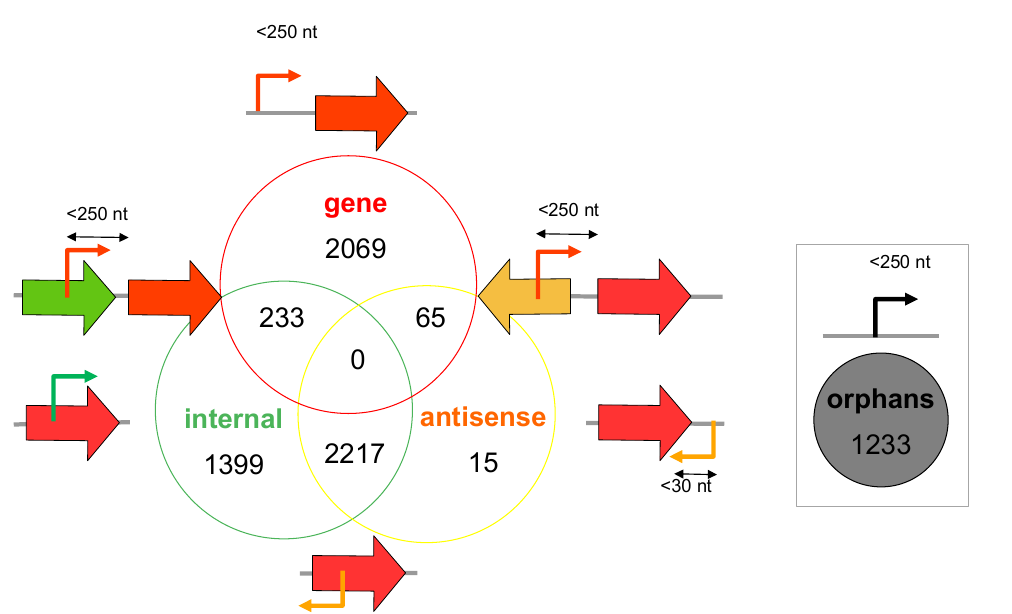
Figure 2. Genome-wide experimentally detected transcription start sites in M. extorquens DM4. TSS categories were defined using TSSAR [34]. Primary TSSs, also called gene TSSs (red circle), locate within 250 nucleotides upstream of an annotated gene. Internal TSSs (green circle) locate within a gene on the sense strand. Antisense TSSs (yellow circle) locate within a gene, or at less than 30 nucleotide distance of a gene, on the antisense strand. This class further splits into Ai and Ad, for internal antisense and downstream antisense, respectively. Orphan TSSs (grey circle) do not locate nearby annotated genes.